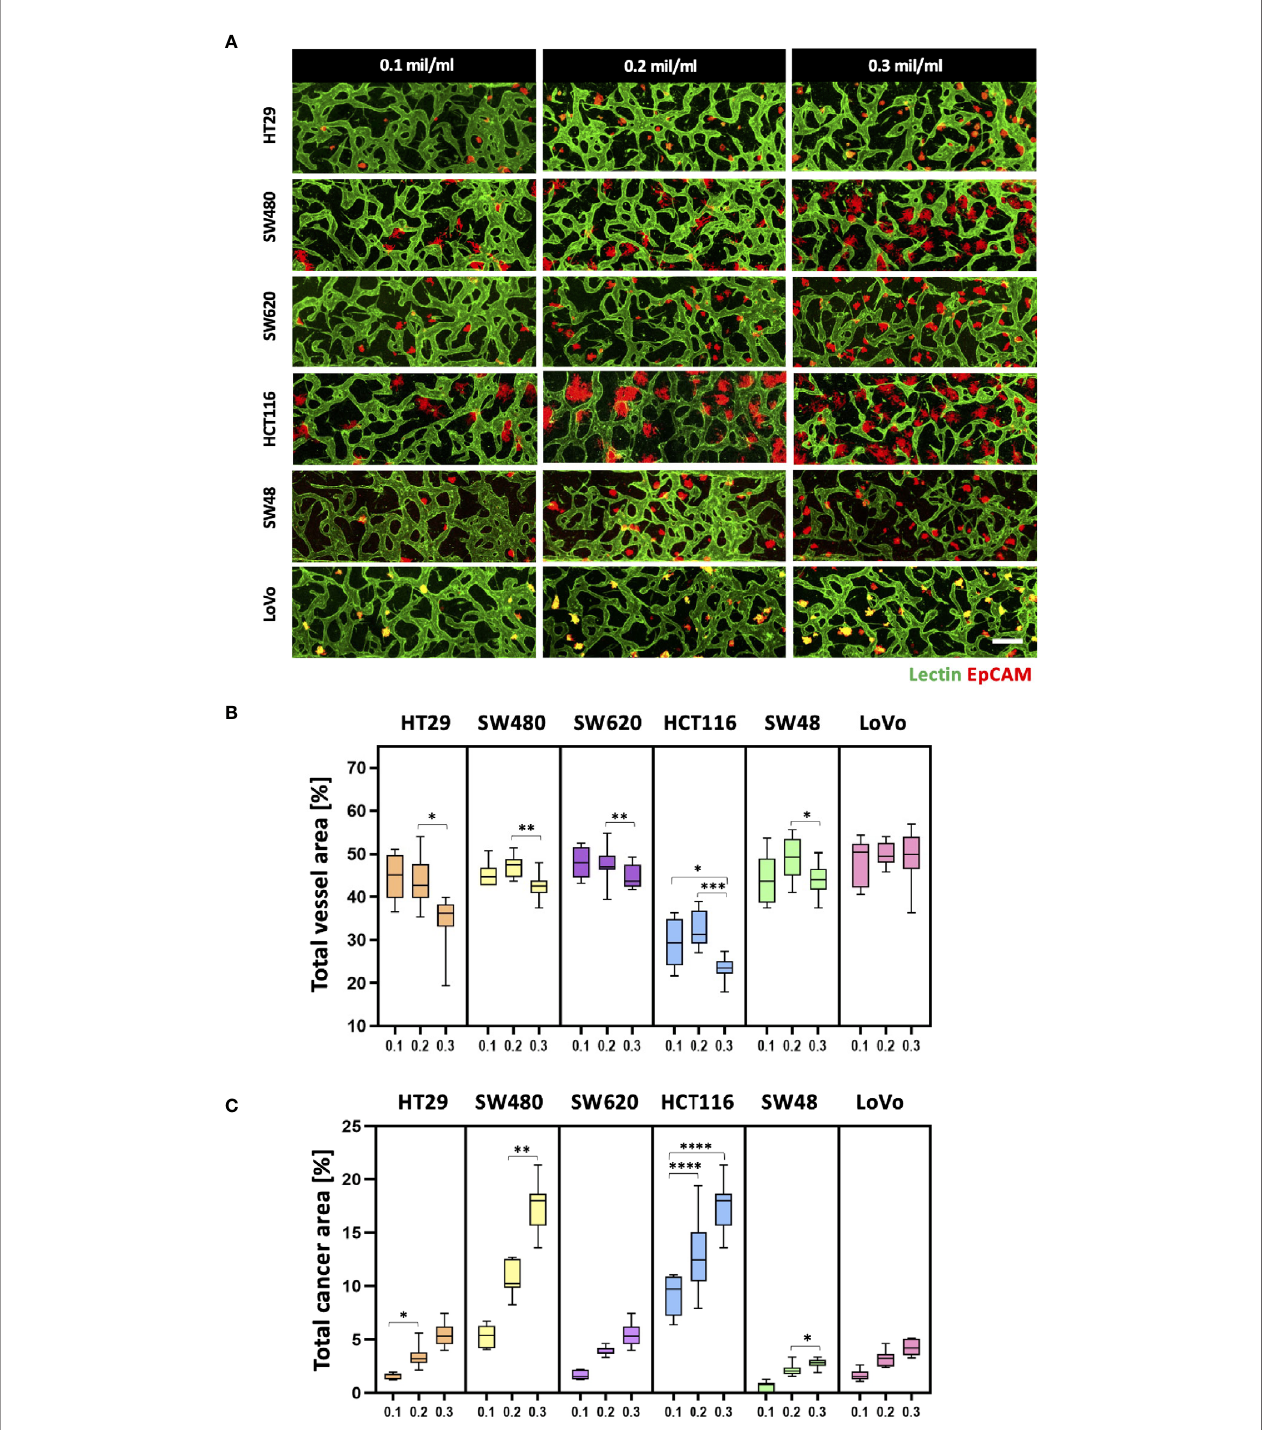
FIGURE 3 | Optimization of CRC cell concentration for the vascularized tumor model. (A) 3D confocal images of blood vessels (lectin, green) co-cultured with CRC cells (EpCAM, red) at three different cancer cell concentrations. (B) Total vessel area for each cancer cell concentration. The cancer cell concentration at 0.2 × 10 6 cells mL -1 was considered the optimal condition for constructing perfusable blood vessel networks in our model while preserving suf fi cient cancer cell cluster sizes. (C) Plot of total cancer area at different CRC cell concentrations. SW480 and HCT116 showed a dramatic increase in total cancer area when cancer cells were initially seeded at high concentrations (n = 14 for each cancer cell line). *p < 0.1; **p < 0.01; ***p < 0.001; ****p < 0.0001. Scale bar = 200